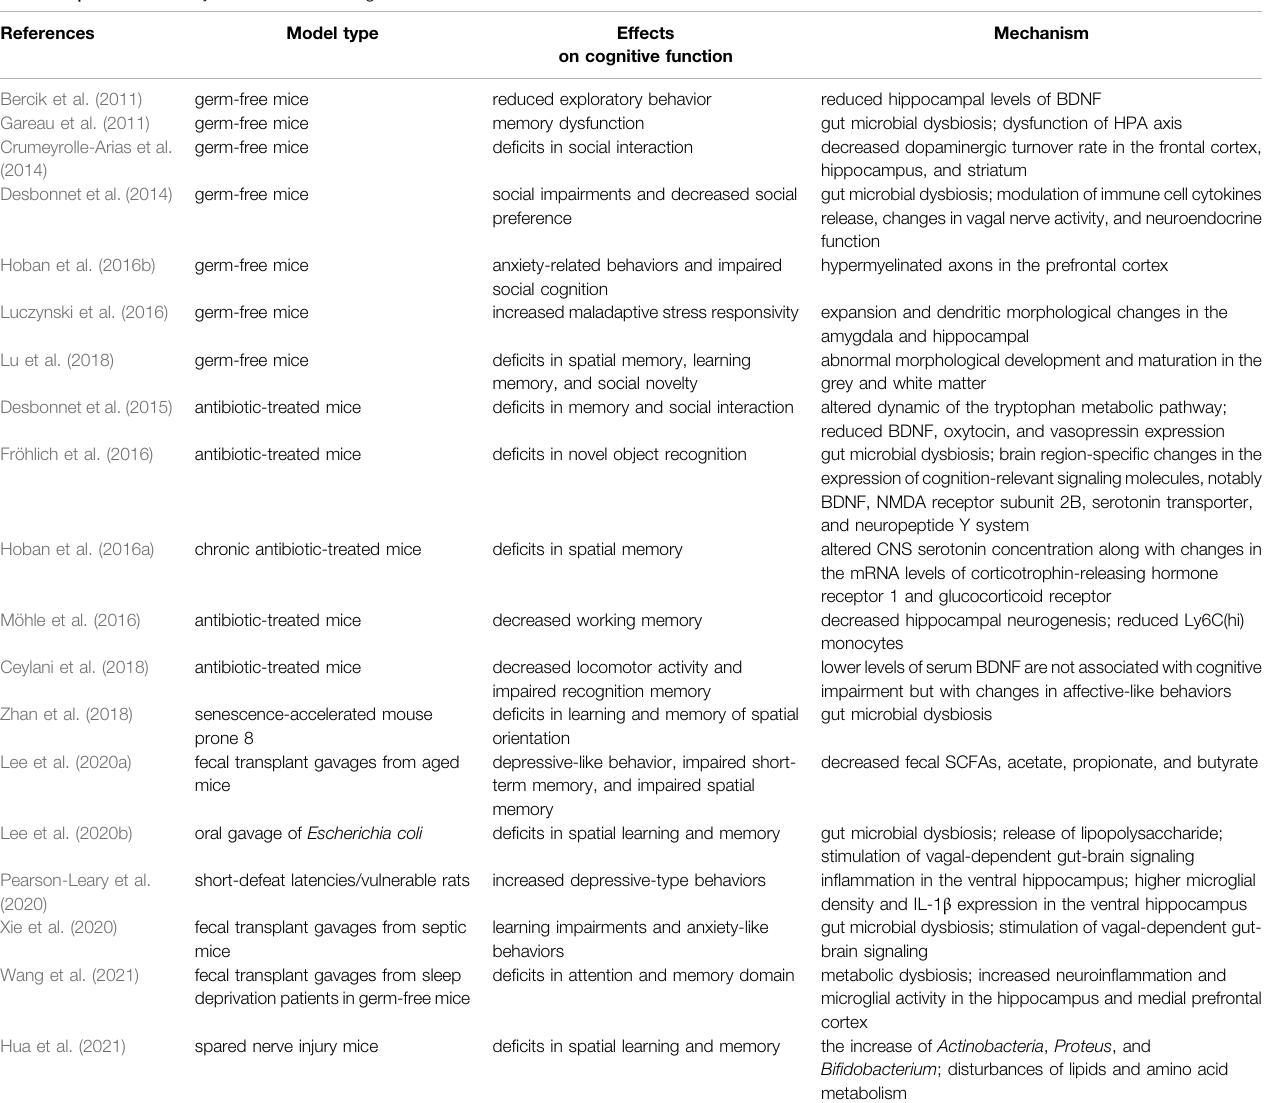
TABLE 1 | Gut microbial dysbiosis can affect cognitive function in rodent